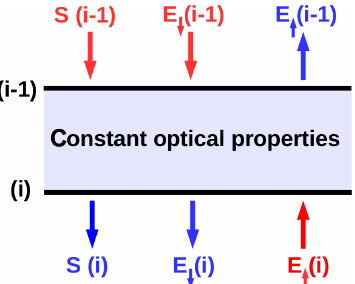
Figure 6. A homogeneous model layer between levels (i − 1 ) and (i) . Incoming radiative fluxes are colored red; outgoing fluxes are colored